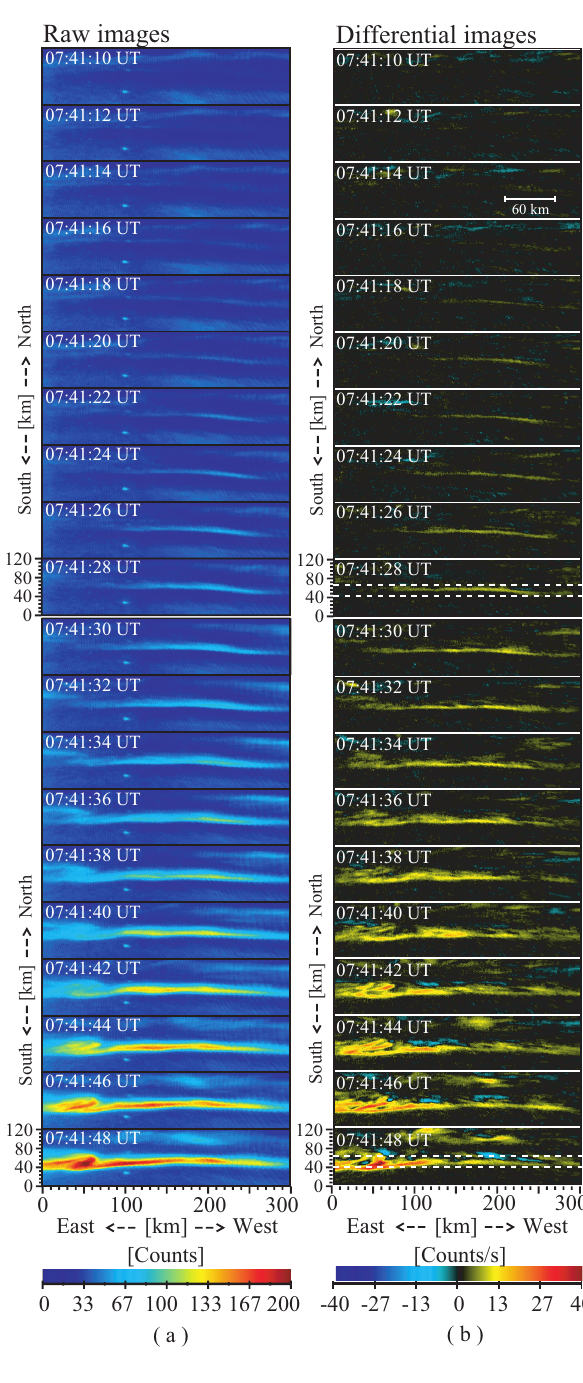
Fig. 3. Temporal sequence of ark-like brightening auroral images every 2s observed at substorm onset at Fort Smith on 7 January 2008. (a) Left column consists of averaged images over 0.1s in false color. (b) Right column consists of differential images, show- ing increase (yellow-red) and decrease (blue) of auroral intensity during 1s. A vertical width between two white dashed lines at bot- tom and middle panels in column (b) indicate the integration range to get Fig. 4b. The magnetic zenith is located at top of